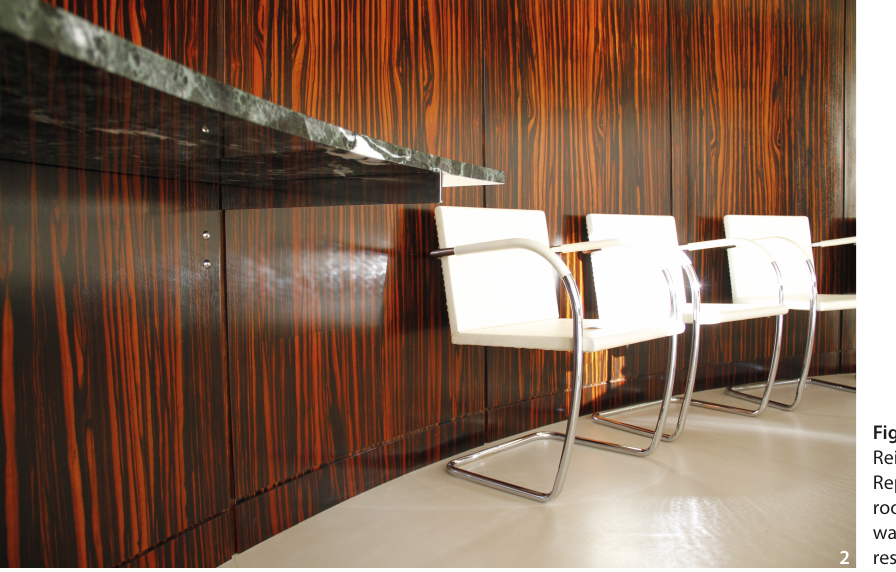
Figure 2 Mies van der Rohe and Lilly Reich, Tugendhat House, Brno, Czech Republic, 1929–1930. Main living room, dining area, the curved inner wall made of Macassar ebony, after restoration (Source: the